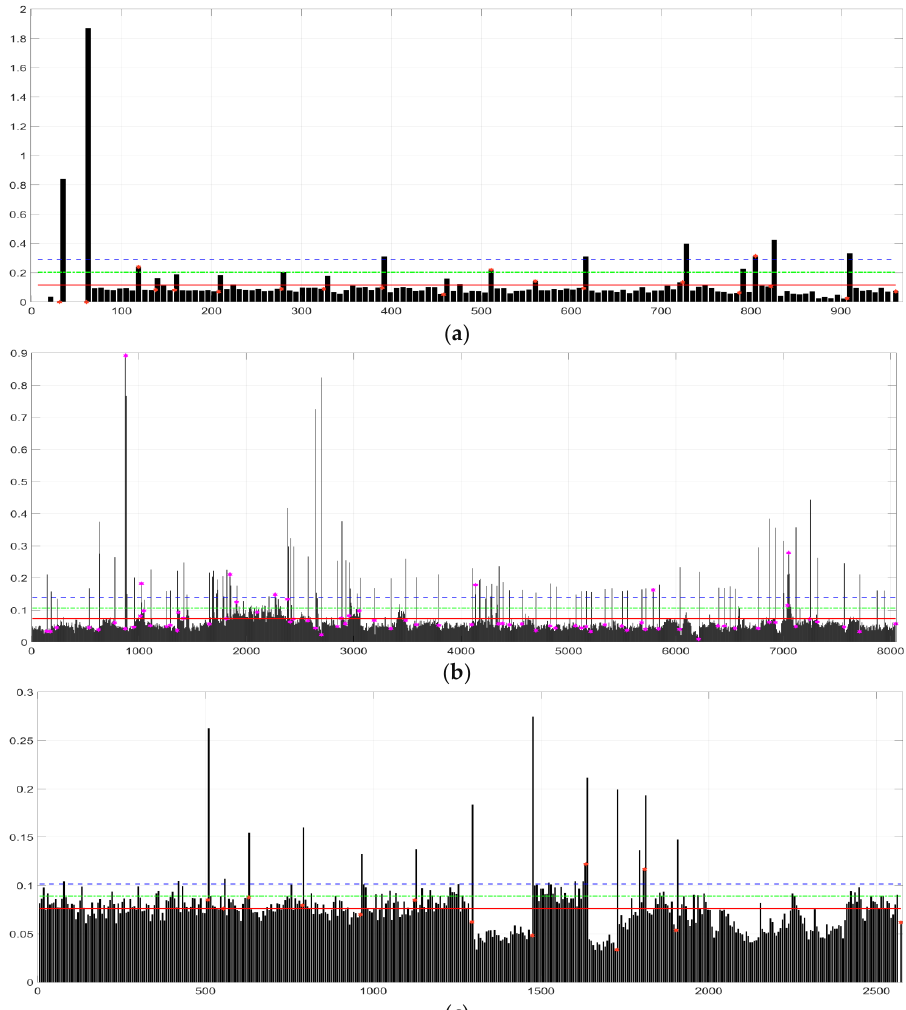
Figure 3. Comparison of the results using LBP-SVD for candidate segment selection. ( a ) LANEIGE, ( b ) Edward Snowden, ( c ) The Sound of Music.